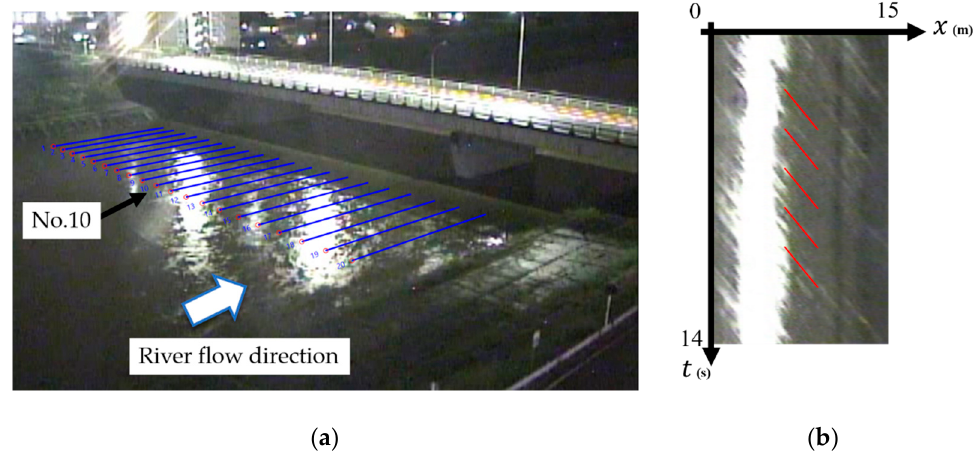
Figure 12. Light case: The nighttime shooting. The reflection from the streetlight makes part of the STI too bright, making it difficult to detect the texture indicating the flow signal. ( a ) Obliquely viewed image; ( b ) STI, No.10 (red lines are CNN estimated angles).